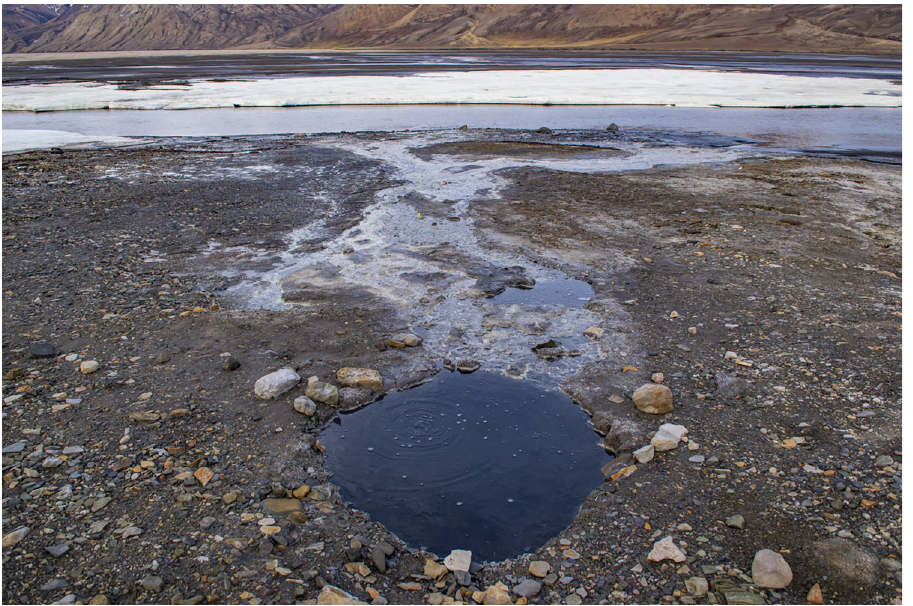
Fig 3. Close-up of Little Black Pond in the Gypsum Hill springs with the Expedition River in the background. The pond is about 1 m in diameter.